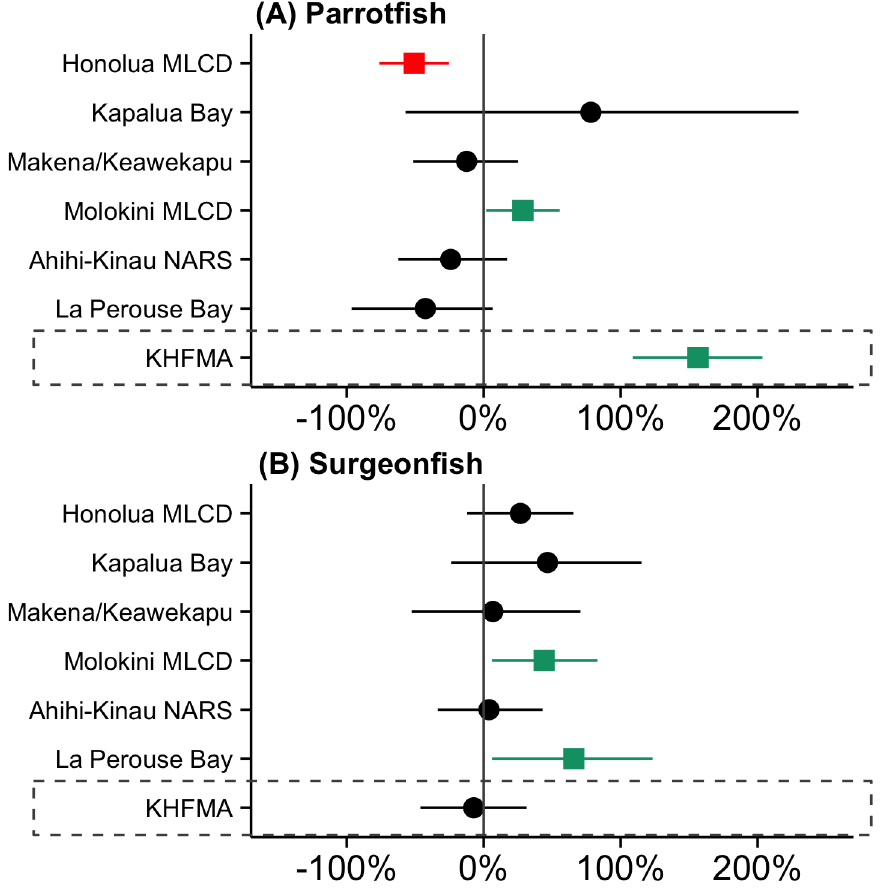
Fig 5. Proportional change between ‘ before ’ (2008 – 9) and ‘ after ’ (2014 – 15) in biomass of (a) parrotfishes > 15 cm and (b) surgeonfishes > 15 cm at KHFMA and comparison locations surveyed by Hawaii DAR. Data points represent mean change in biomass, and lines are 95% quantile range (95%QR) of that change. 95%QR not overlapping zero is evidence of a significant difference between time periods, shown as a green square (increase) or red square (decrease). As two species of surgeonfish ( A . nigrofuscus and Z . flavescens ) and all fishes < 15 cm TL are not recorded during surveys at Maui comparison sites, observations of those species or size class are also not included in KHFMA data for this